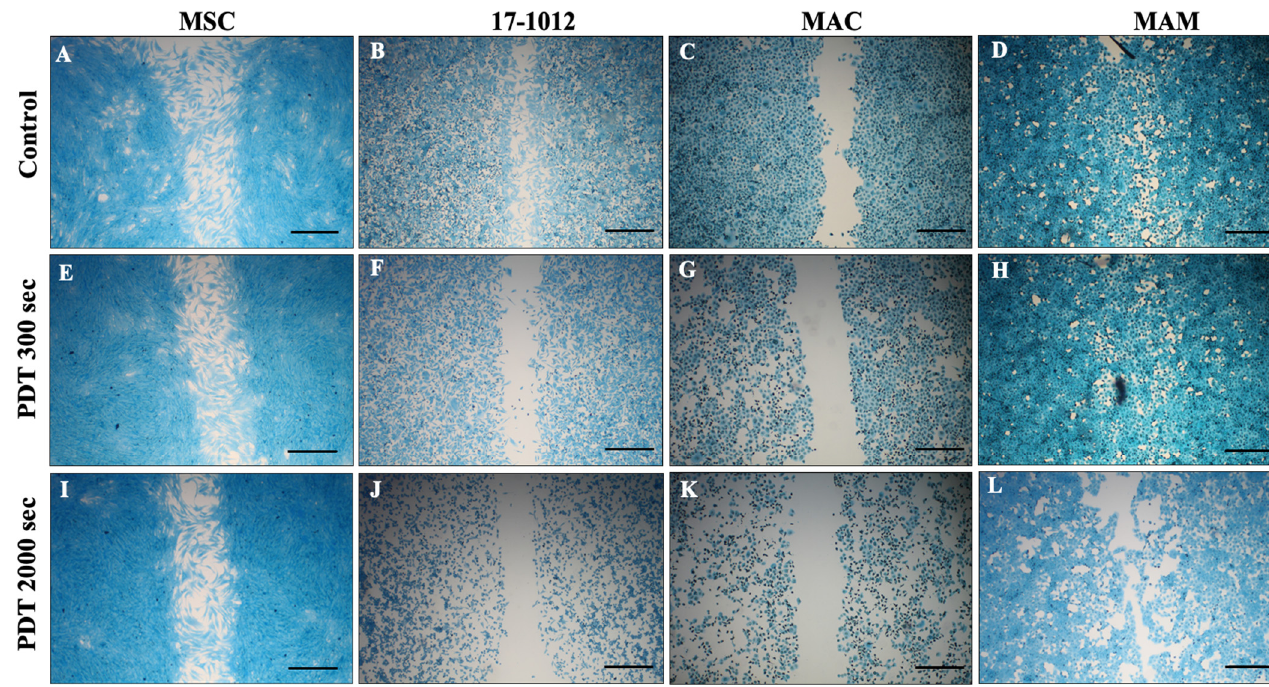
Figure 1. Effect of PDT exposure on primary bone tumor and metastatic bone cell lines. All cell lines (17-1012—giant cell tumor of bone ( B , F , J ), MAC—bone metastases of invasive ductal breast carcinoma ( C , G , K ), MAM—bone metastases of renal cell carcinoma ( D , H , L ), and MSC as a control ( A , E , I )) were subjected to PDT exposure for predefined time frames of either 300 sec or 2000 sec with 5-ALA as a photosensitizer at a concentration of 1.5 mM). Ten-fold magnification, scale bar (black) represents 300 μ m. Abbreviations: 5-ALA—5-aminolaevulinic acid, PDT—photodynamic therapy, sec—seconds.